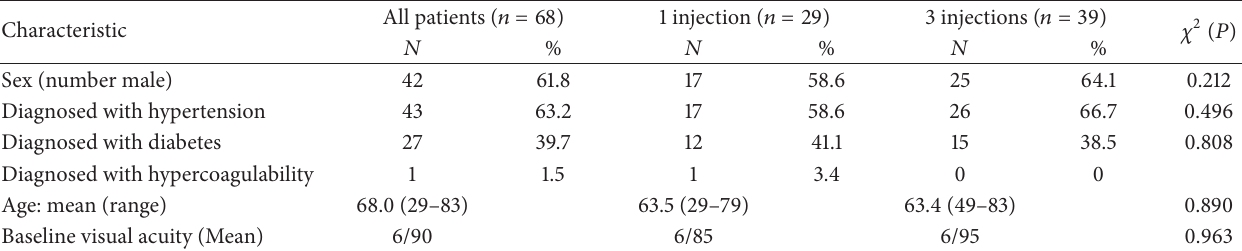
Table 1: Demographic data and incidence rates of selected diseases.